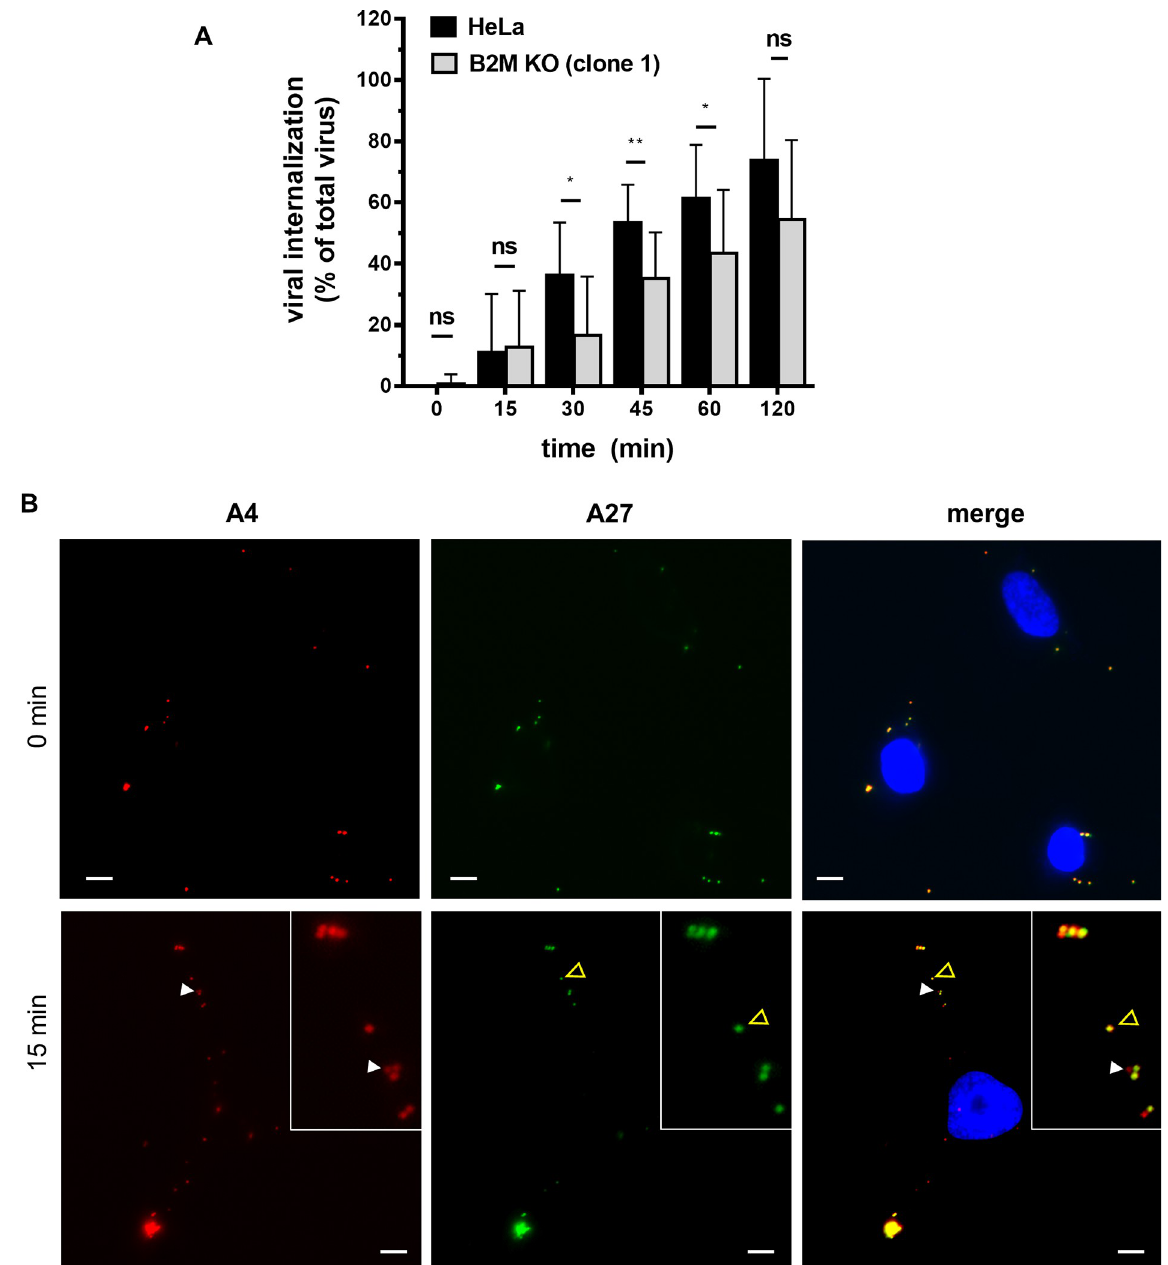
Fig 8. B2M gene inactivation affects VV internalization. A) and B) HeLa and B2M KO cells were infected with V -A4-cherry at m.o.i. = 4 during 1 h at 4˚C to avoid internalization. Cells were incubated for different times at 37˚C and non-permeabilized cells were stained with antibody to VV-A27 (green) to visualize cell surface virus particles. White arrow-heads mark internalized virions (only red in merged image) and yellow-empty arrow-heads indicate non-internalized virions (green or yellow). Cell nucleus was labeled in blue by Hoechst staining. Internalized virions were quantified for each time point showing significant differences between HeLa and B2M KO cell lines. p-values: ���� < 0.0001, ��� < 0.001, �� < 0.01, � < 0.05, ns > 0.05. Scale bars: 5 μ